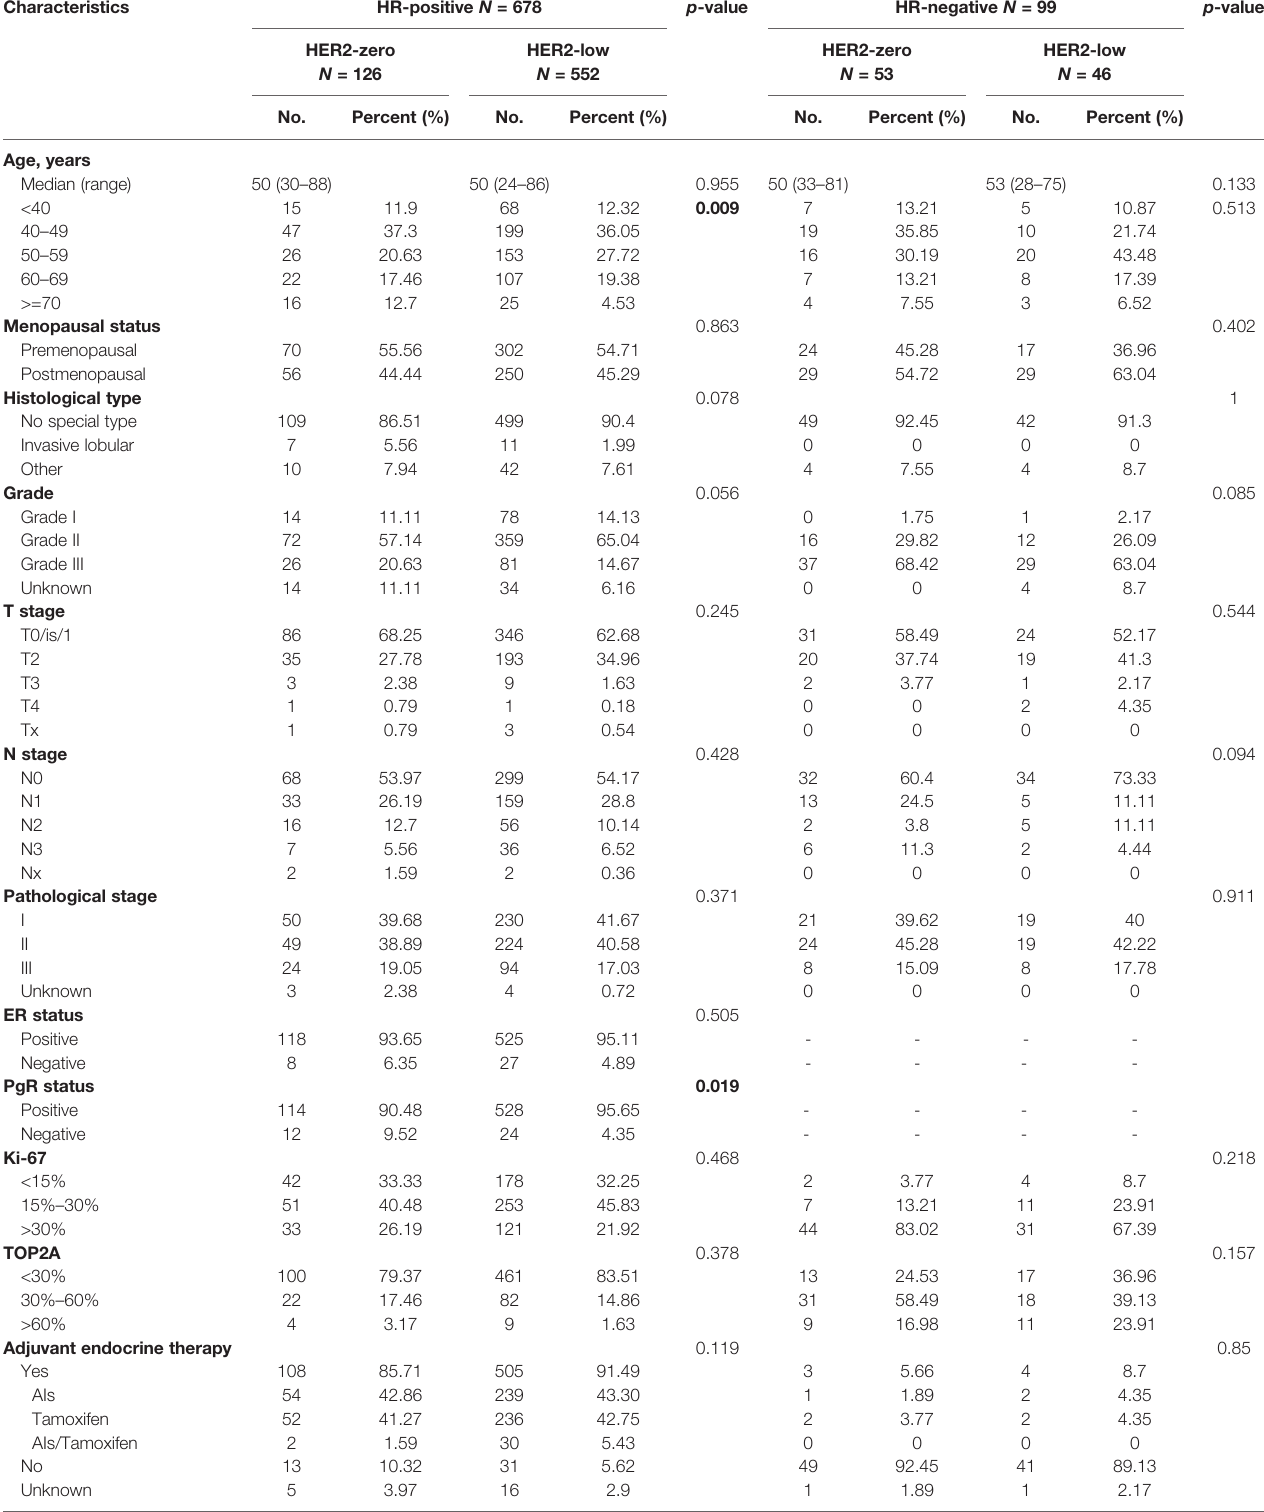
TABLE 1 | Baseline characteristics strati fi ed by HR status.